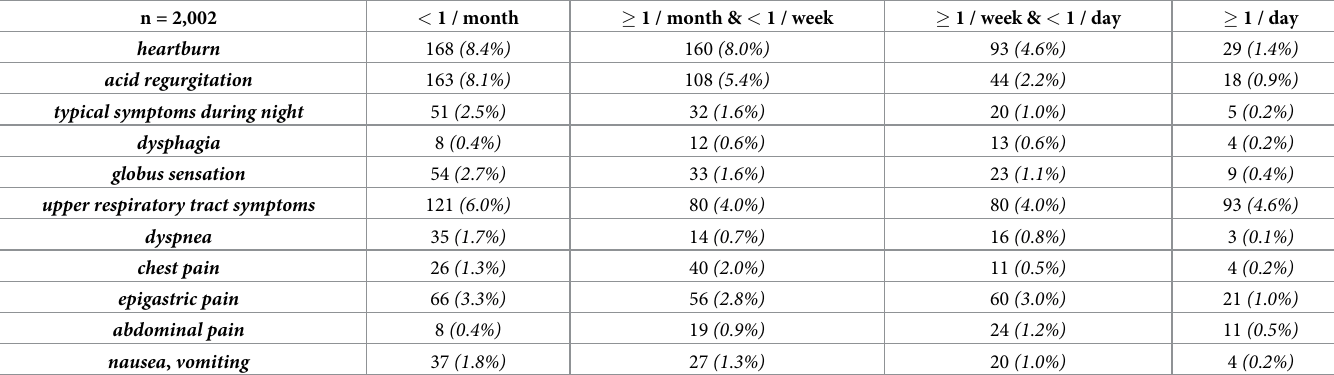
Table 2. The prevalence and frequency of different GERD-related symptoms.